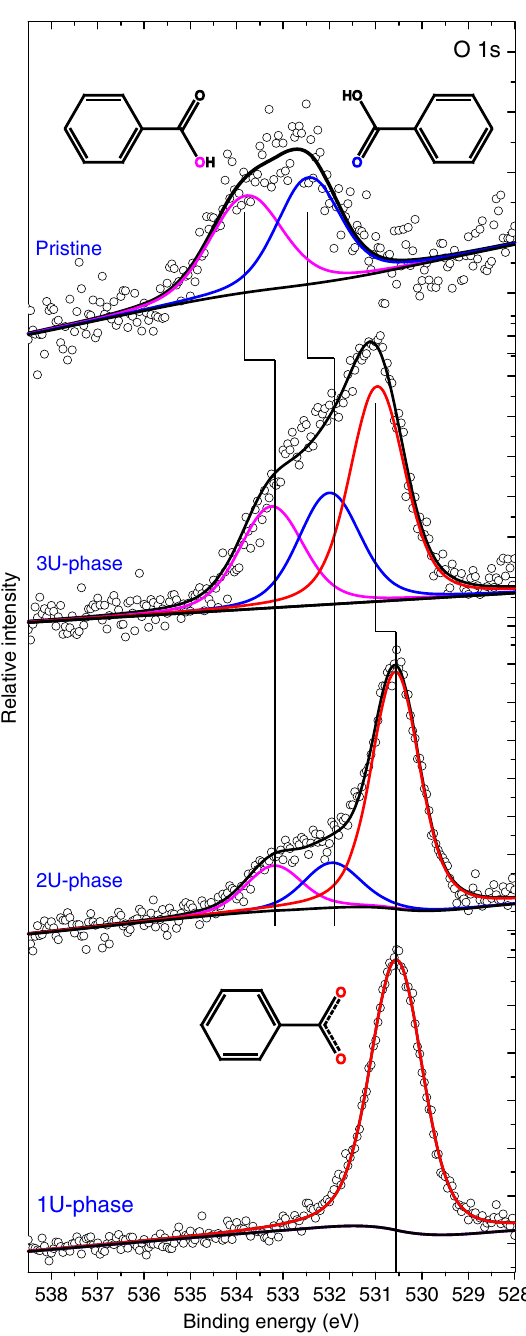
Fig. 2 XPS analysis. Detailed O 1s spectra measured on samples with BDA with 1U- to 3U-phases and a molecular phase comprising pristine BDA molecules. Spectra were acquired in high magni fi cation mode using the pass energy of 20 eV integrating up to 180 sweeps with 0.1 s dwell time and 0.05 eV energy step. See Supplementary Discussion, X-ray photoelectron spectroscopy analysis, for details on XPS n of the polygons that meet at each vertex; the sequence of i polygons is listed in a clockwise direction 1 . If two or more identical polygons are neighboring their count is given by exponent α . i